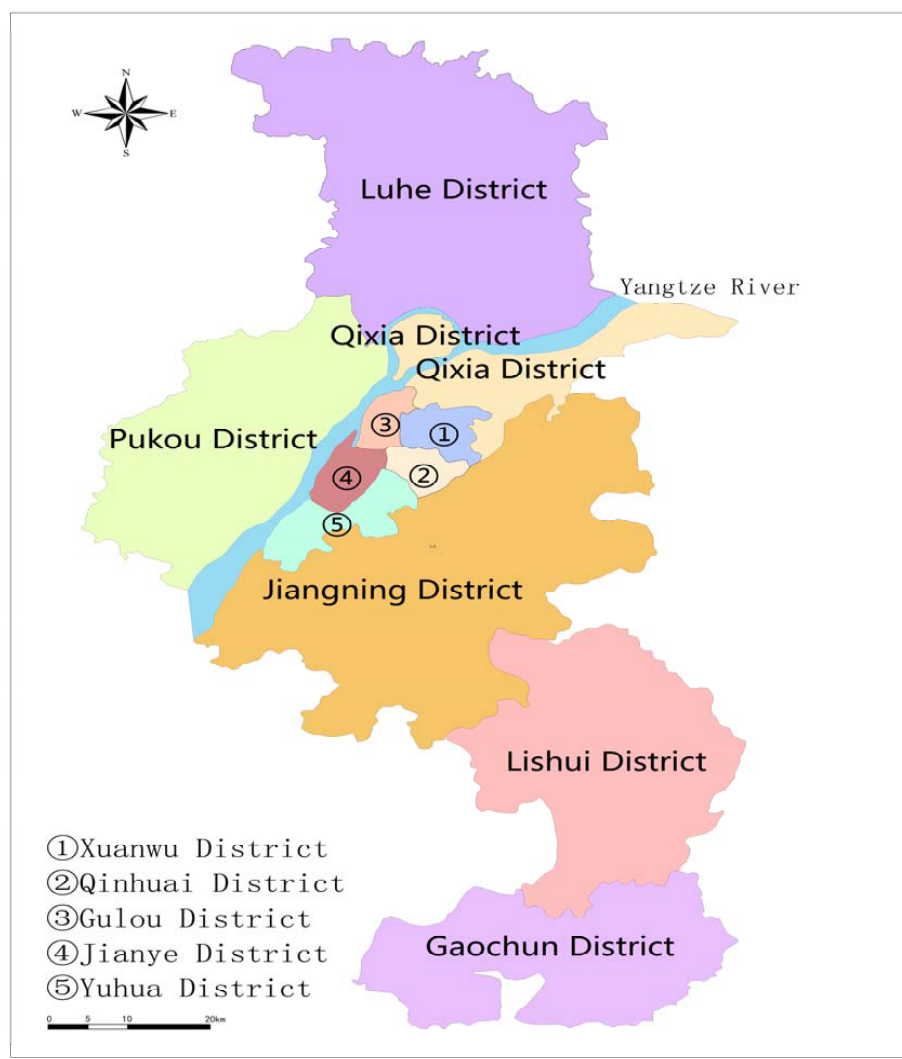
Figure 1. Administrative divisions of Nanjing.